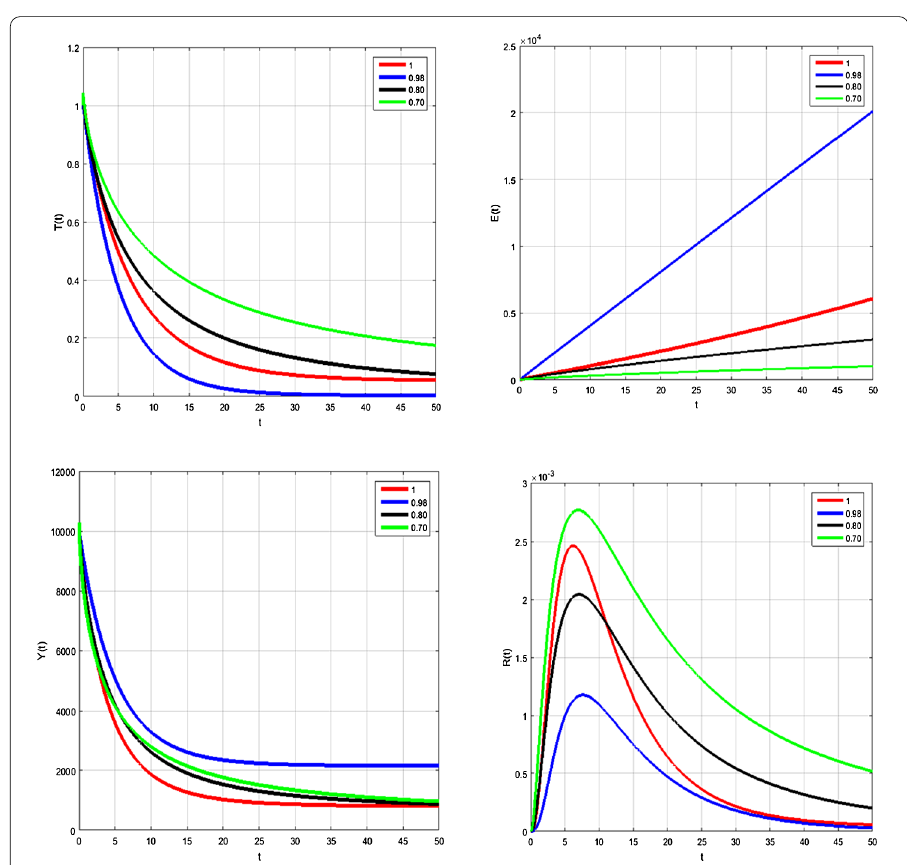
Figure 3 The state variable simulations by N2LIM at different α